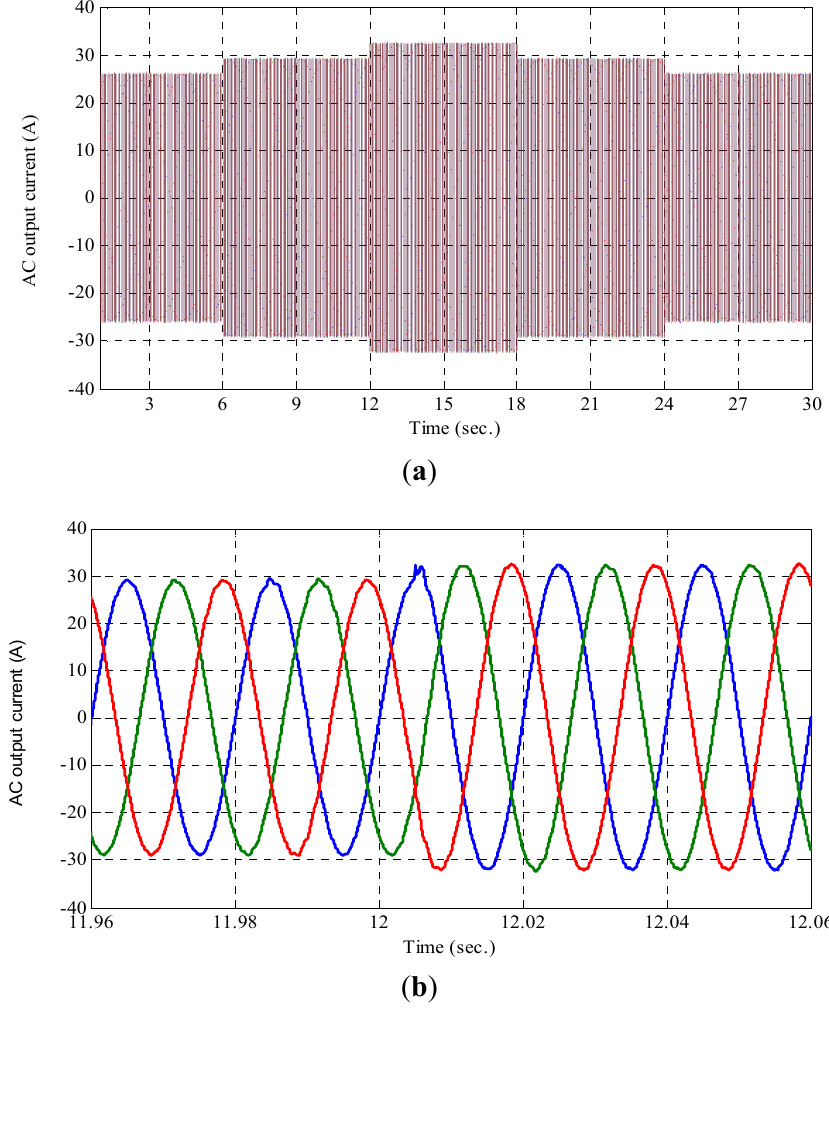
Figure 17. Output load currents response with change in required load power. ( a ) AC output load currents thoughout the time simulation; ( b ) Load currents at the instant of step up load power at time = 12.005 second; ( c ) Load currents at the instant of step down load power at time = 24.005